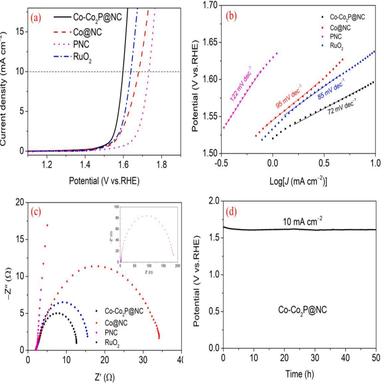
(a) OER polarization curves; (b) Tafel plots; (c) Nyquist plots; (d) Chronopotentiometry curve of Co-Co2P @ NC without iR compensation.